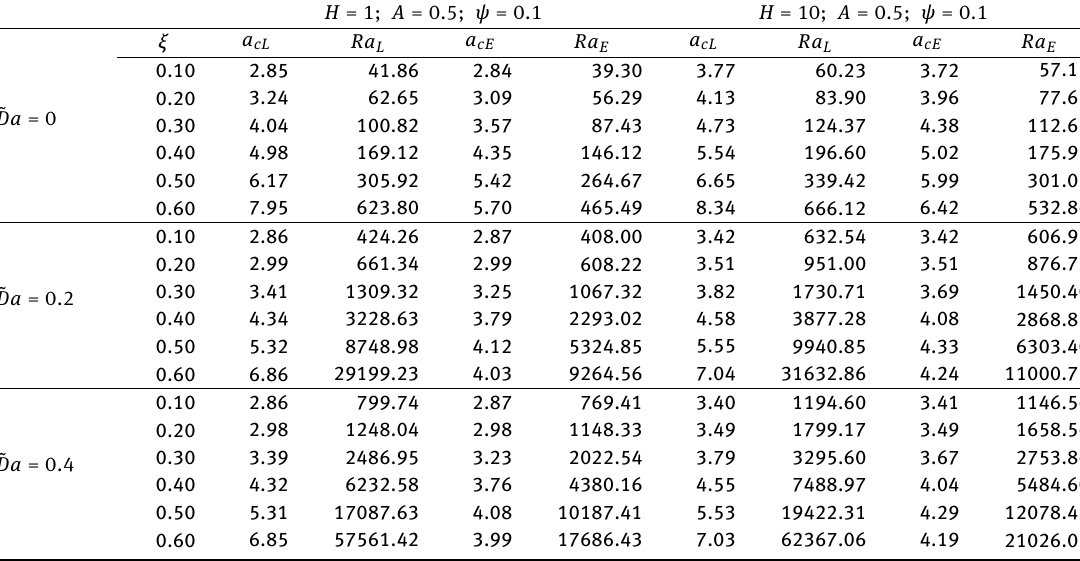
Table 3: variation of critical Rayleigh number ( Ra L , Ra E ) with internal heat parameter ( ξ ) at fixed values of ˜ Da , H , A , ψ for case B of lin- early increasing heat